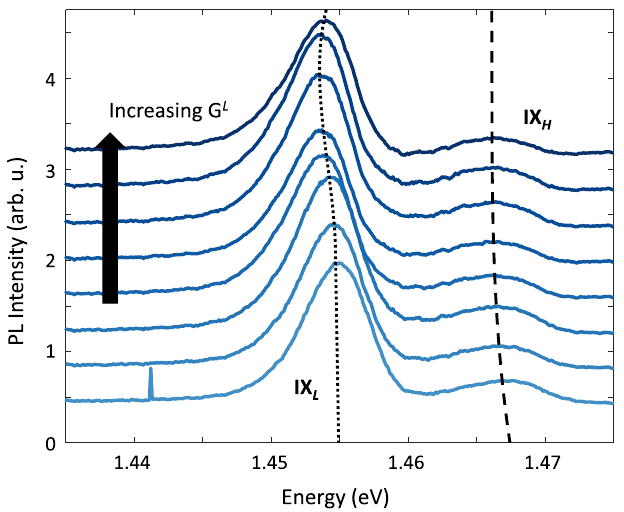
FIG. 8. Spatially integrated PL spectra for the IX L (around 1.455 eV) and IX H (around 1.468 eV) resonances as a function of the IX L excitation power G L (from bottom to top: G L ¼ 0 (lightest), 10, 20, 30, 43, 55, 80, 130 (darkest) μ W). The electric field is 38 kV = cm and G H ¼ 40 μ W. Data is taken from sample A, but is the equivalent experiment for sample B shown in Fig. 5 of the main text. Each integrated spectrum is normalized with respect to its maximum intensity to allow easy comparison of the energetic red shifts with increasing IX L intensity. The energy of the IX L and IX H transitions are marked by the dot and dashed lines, respectively. Each of these spectrum would be equivalent to a single data point in Fig. 5.